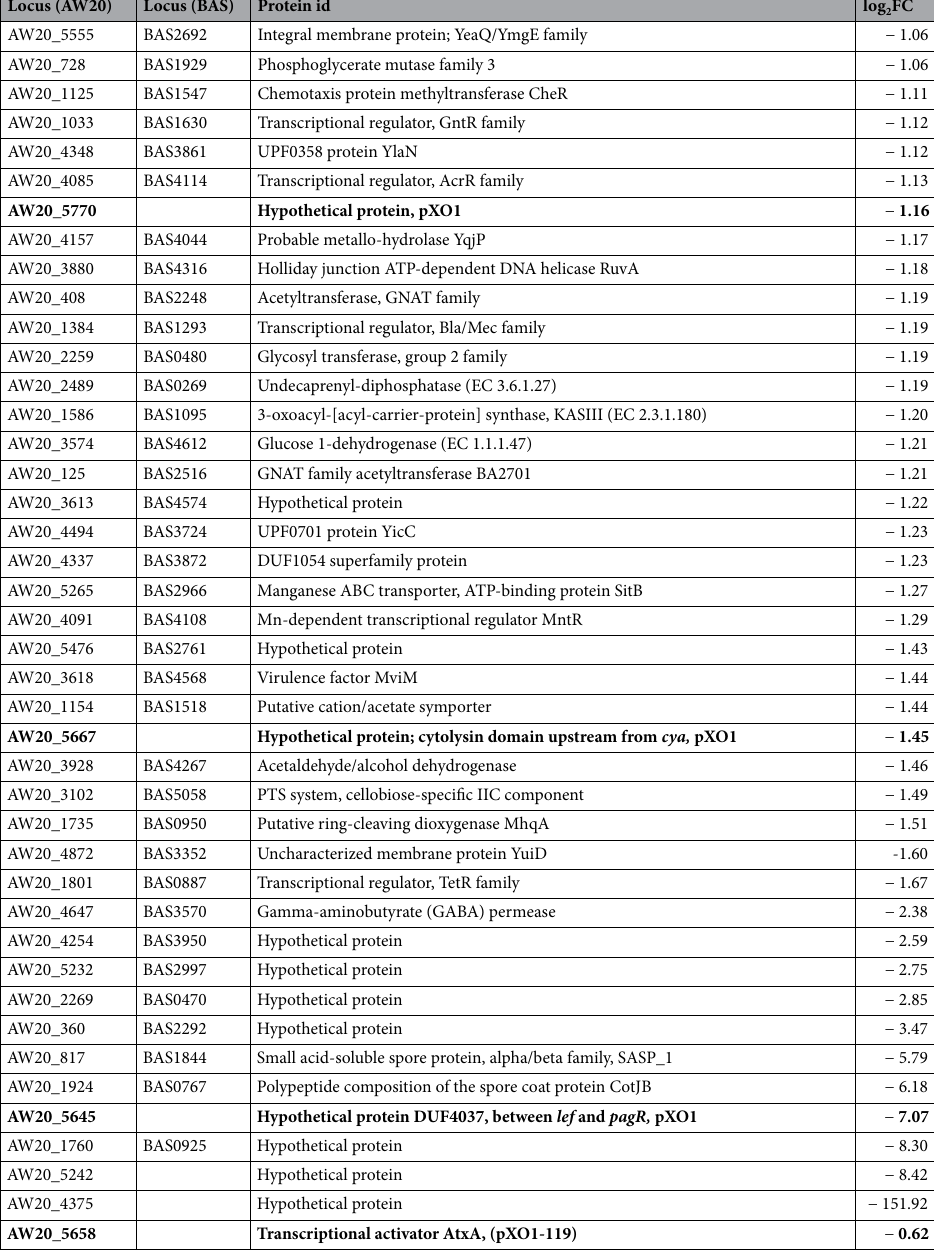
Table 3. Significant genes from the the 2 h timepoint. atxA did not experience a significant fold-change however the FDR did make the cutoff. Bolded entries indicate the gene is present on the virulence plasmid pXO1. Gene loci are listed according to NCBI Sterne RefSeq assembly GCF_000832635.1 (Locus AW20) with the RefSeq assembly GCF_000008165.1 loci provided (Locus BAS) where available. Protein name and functions are according to PATRIC and the log 2 FC are